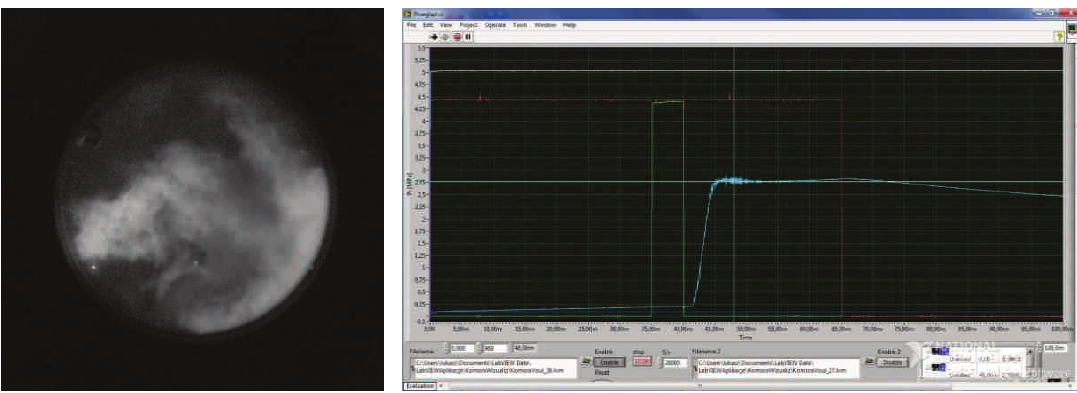
Fig. 5a. Photo of combustion progress and pressure course with marked pressure value 8ms after combustion initiation. Combustion initiation – 40 ms after opening of injector